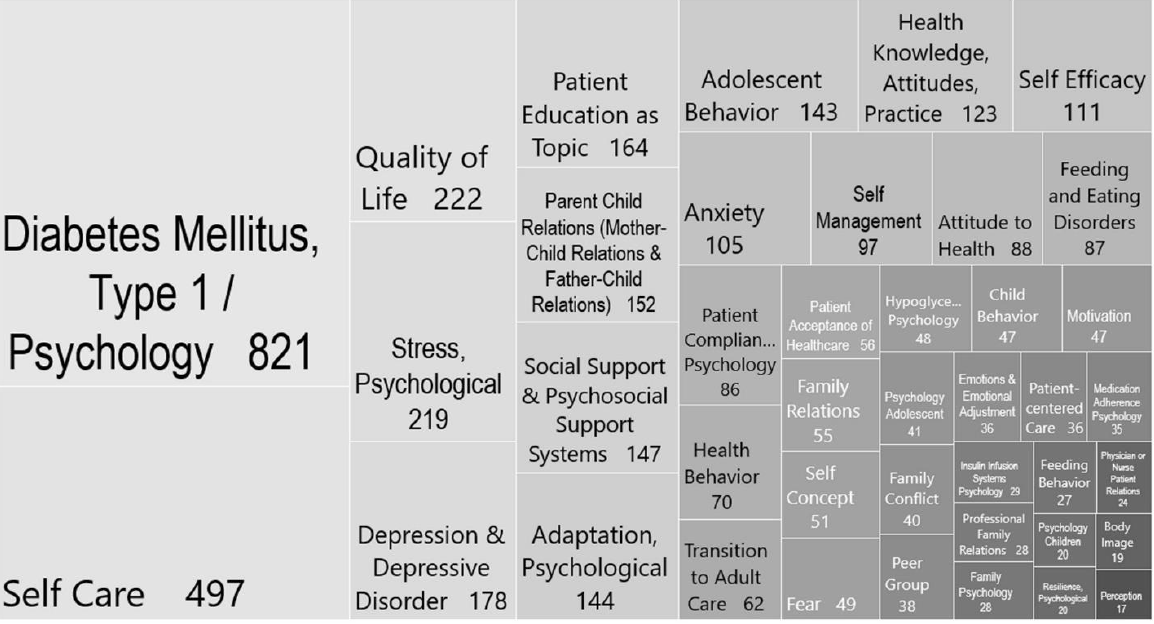
Figure 3 Frequency of assigned MeSH